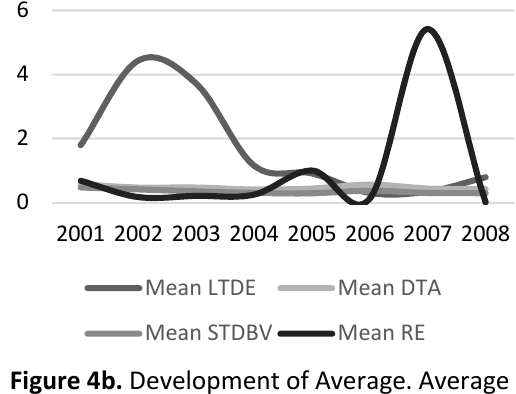
Figure 4b. Development of Average. Average